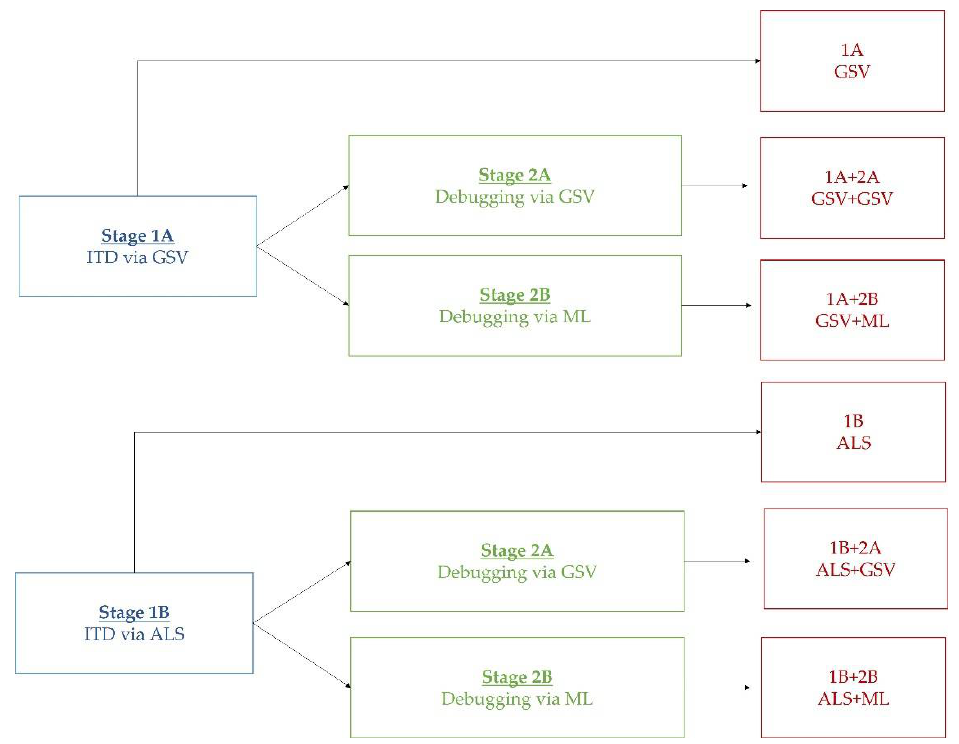
Figure 3. Flowchart of the different stages of the proposed methodology.